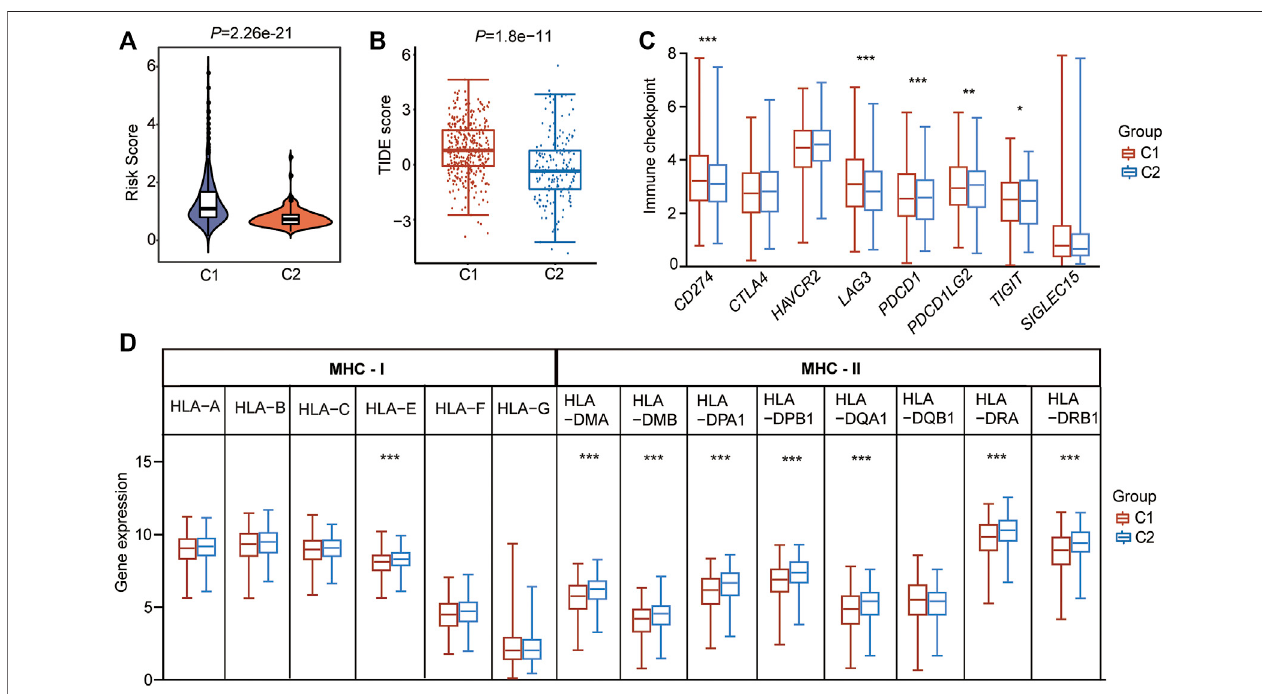
FIGURE8| CSRsareassociatedwithimmunizationcheckpointblockinLUAD. (A) Theriskscoreinthetwoclusters. (B) TheTIDEscoreinthetwoclusters. (C) The immunecheckpointgenesinthetwoclusters. (D) TheHLAfamilygenesinthetwoclusters.Thestatisticalsigni fi cancewascalculated via Wilcoxonrank-sumtest,*** p < 0.001, ** p < 0.01, * p <